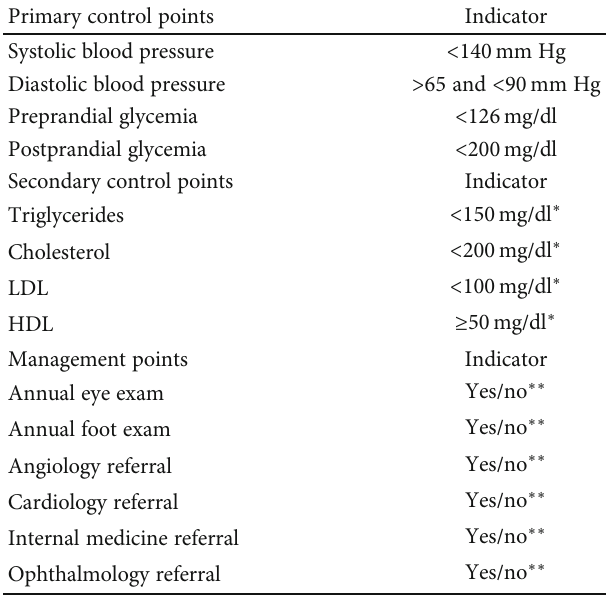
∗ Mean values during the study period. ∗∗ Action performed at least 1 time during the study period (2012-2015). LDL: low-density lipoprotein; HDL: high-density